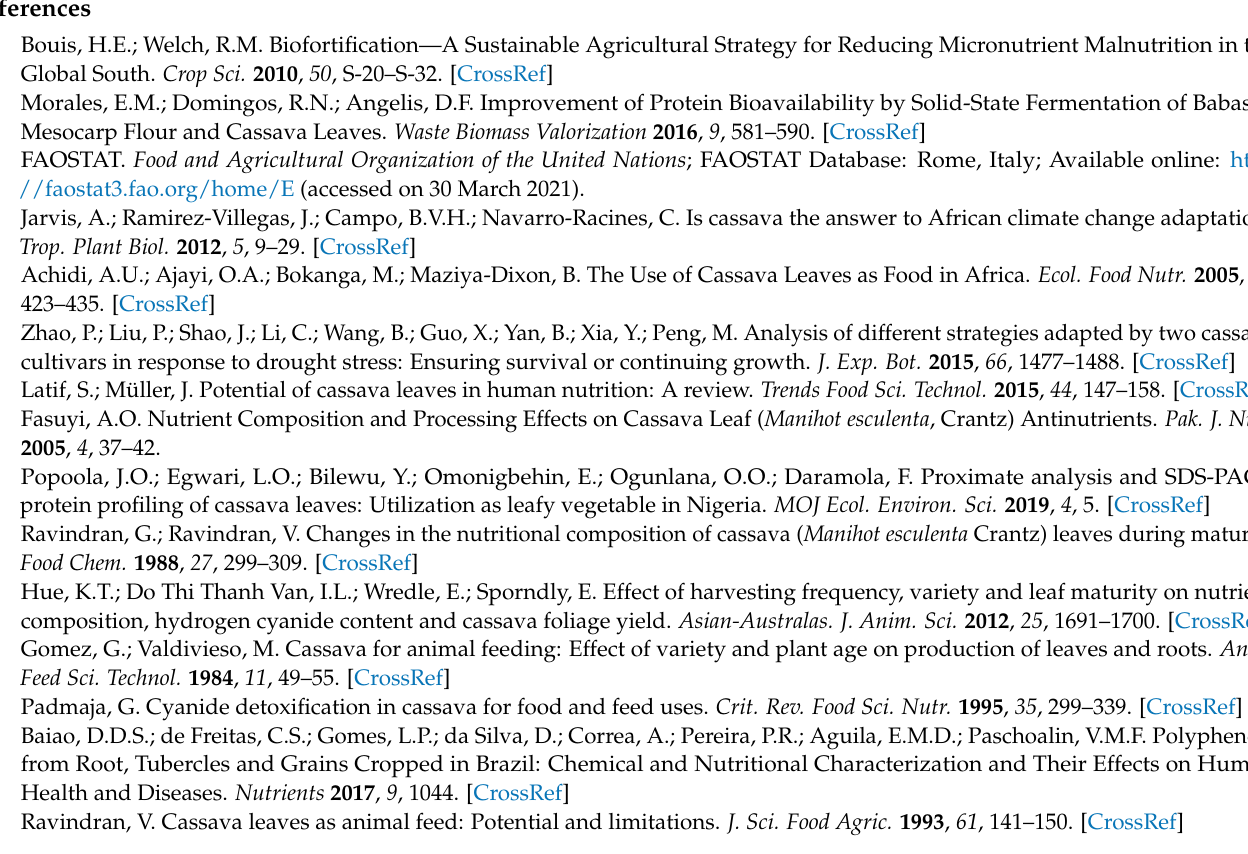
Figure A1. Calibration curve for TPC (R 2 = 0.9985) based on the gallic acid equivalent, showing absorbance (ABS) as a function of the GAE equivalent (ABS = 4.715 GAE–0.004).